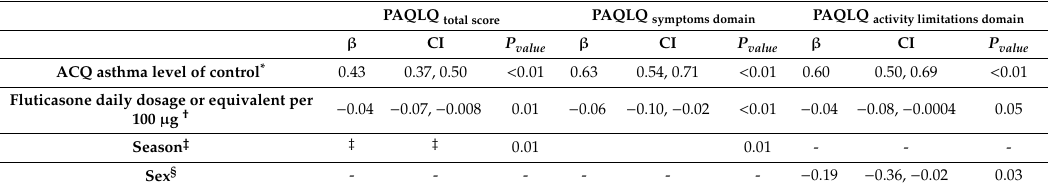
Sex § - - - - - - − 0.19 − 0.36, − 0.02